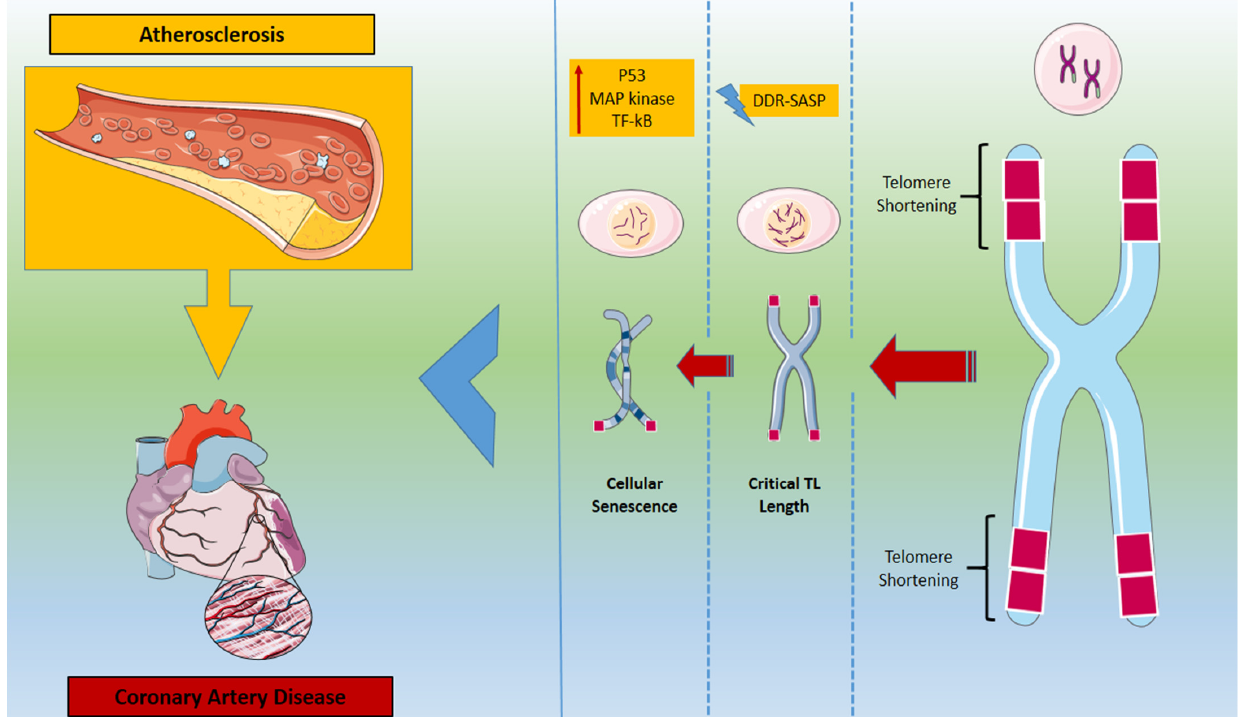
Figure 1. Telomere length shortening and its effect on atherosclerosis progression and coronary artery disease. DDR: DNA-damage-response; SASP: senescence-associated secretory phenotype; TF-kB: nuclear factor kappa-light-chain-enhancer of activated B cells.